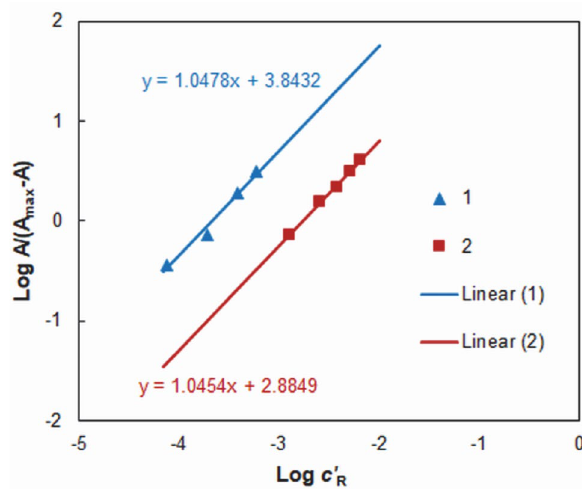
Figure 5. Determination of the TAO/V V (1) and A336/V V (2) molar ratios by the mobile equilibrium method. The experimental condi- tions are given in Fig.